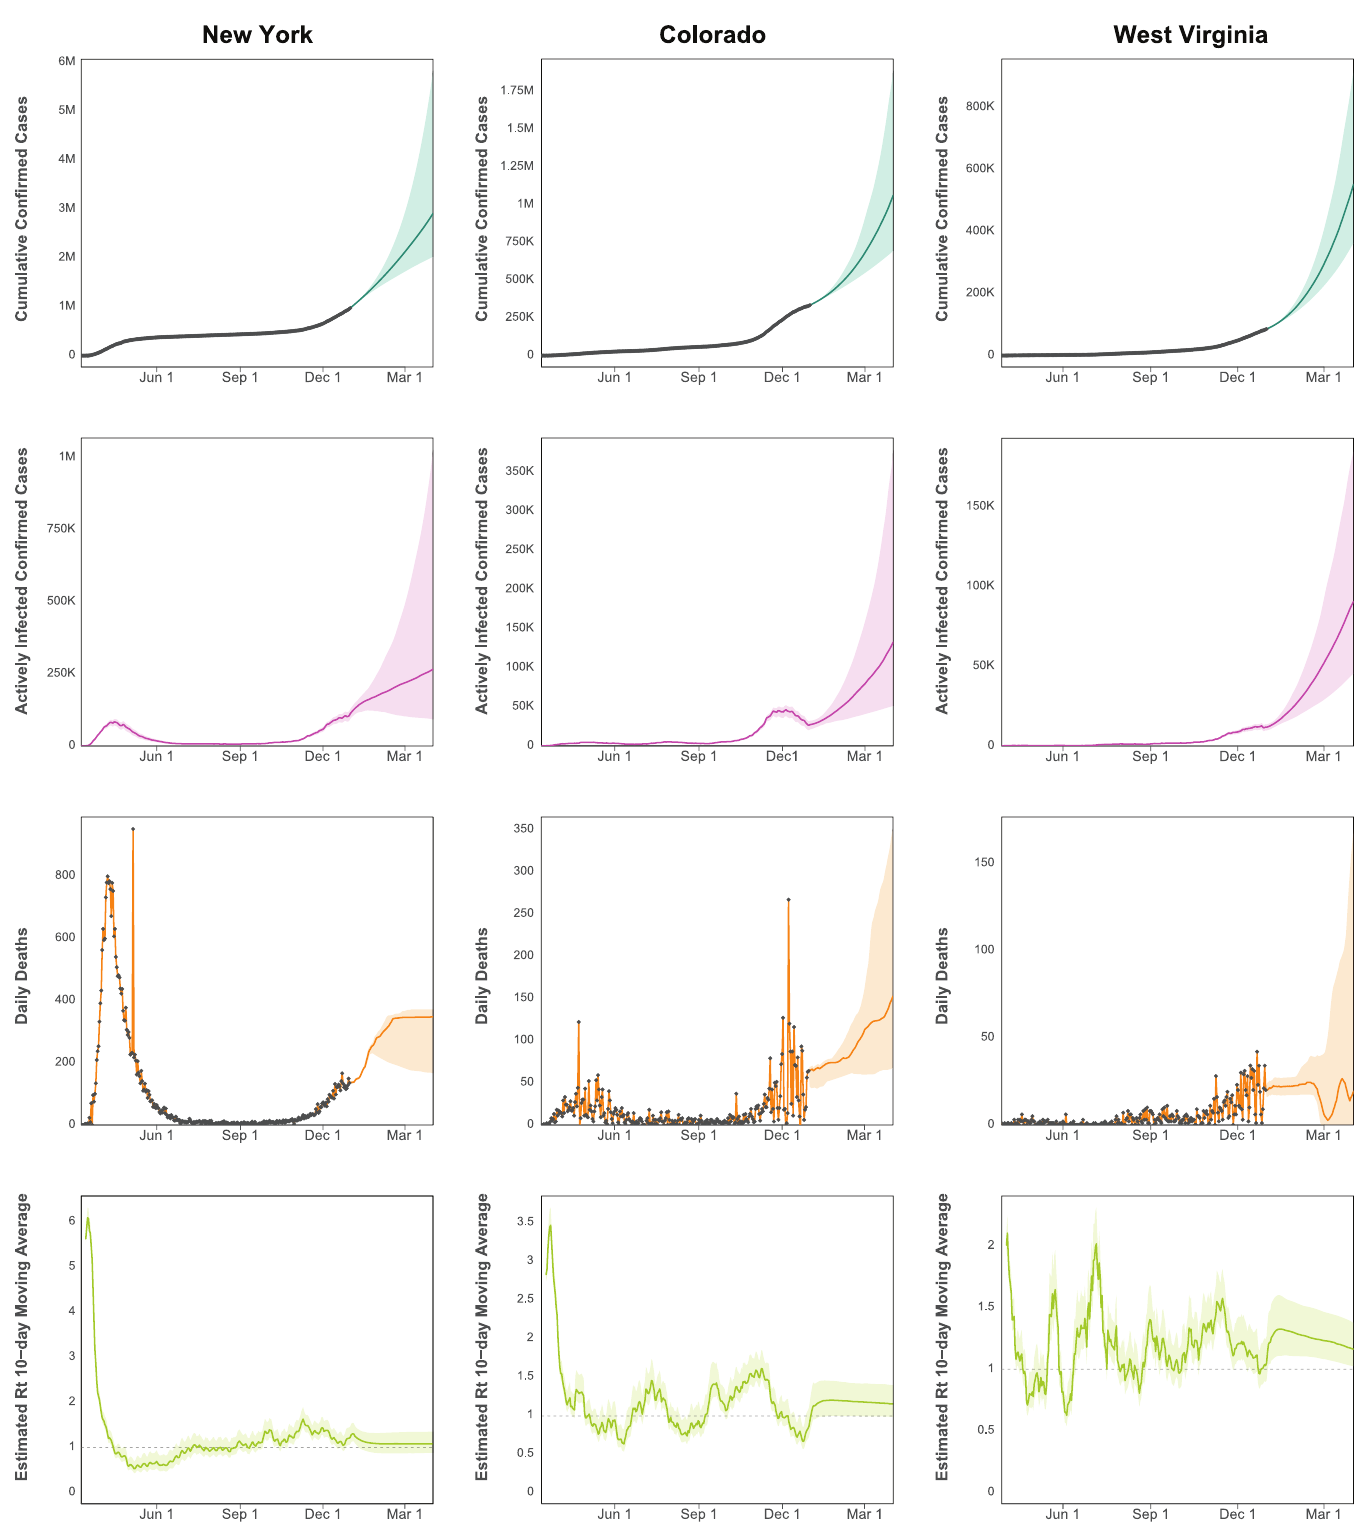
Fig 5. Predicted cumulative cases, active infections, deaths, and effective R April 1, 2021, for New York, Colorado, and West Virginia. The grey dots indicate observed data, which are not available for active infections and R t .